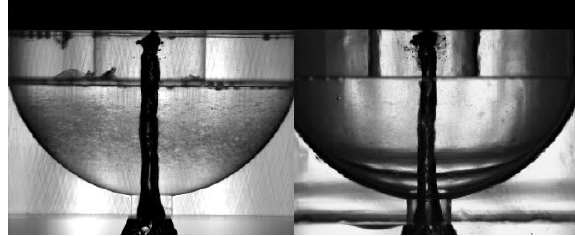
Fig. 3. High-speed image, left: p-Cymene, right: